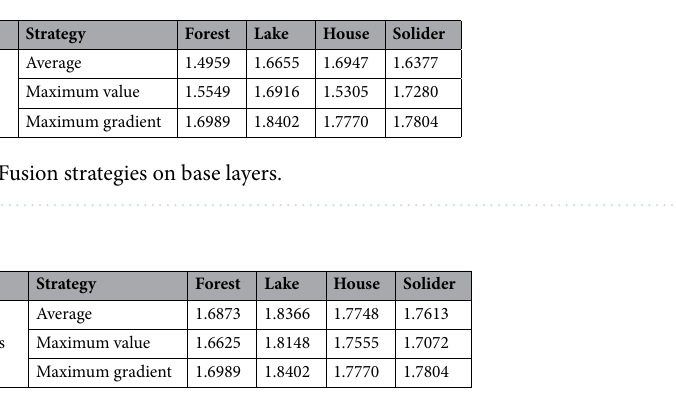
Table 4. Fusion strategies on detail